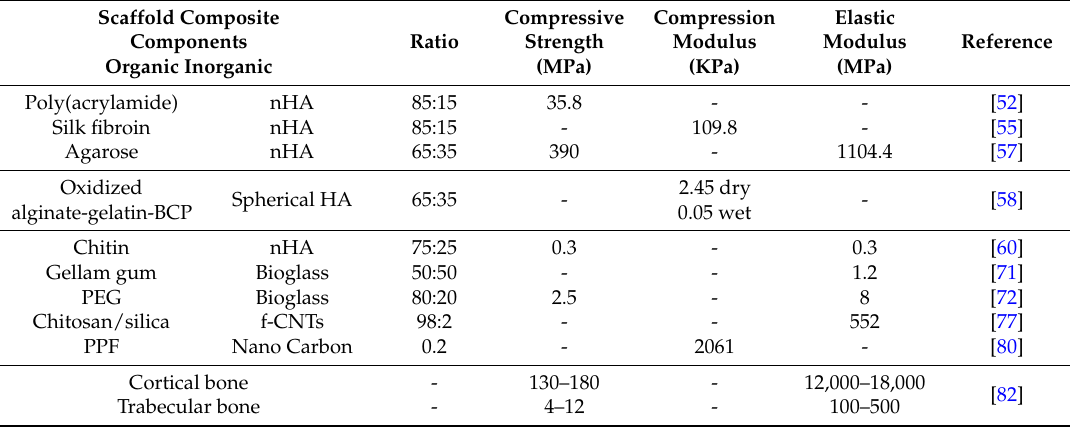
Table 1. Mechanical properties of composite hydrogels containing inorganic